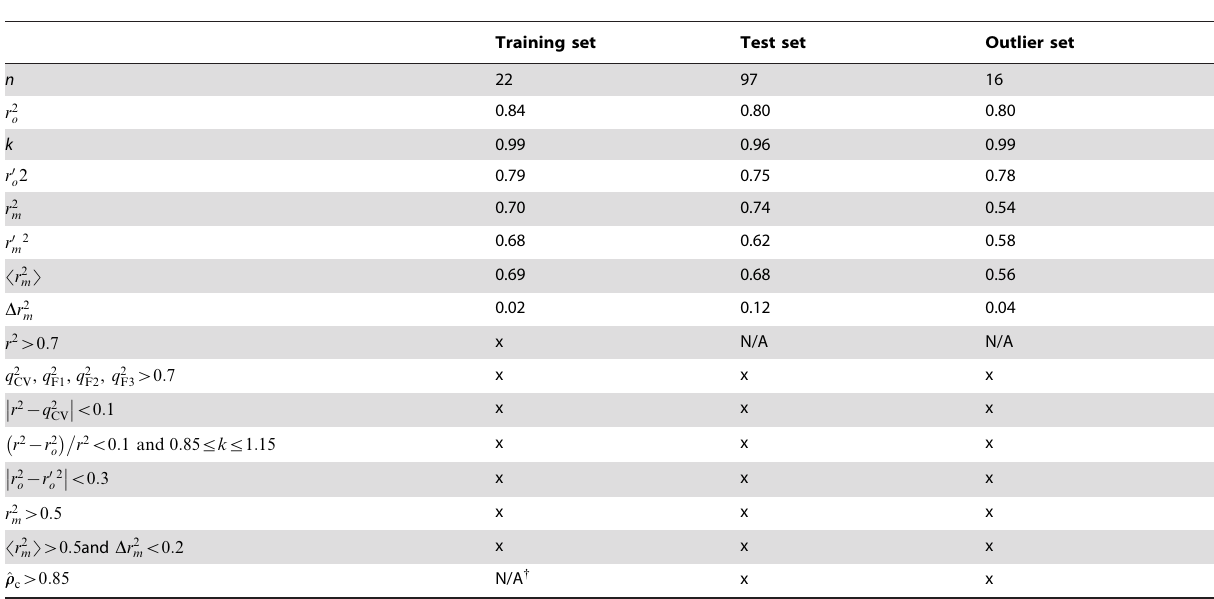
Table 5. Validation verification of PhE/SVM based on prediction performance of those molecules in the training set, test set, and outlier